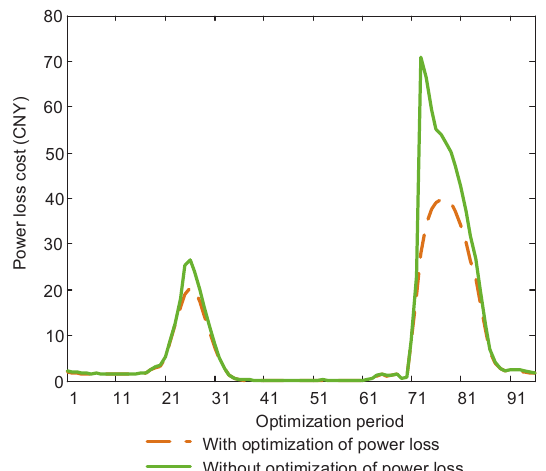
Figure 11. Power loss cost comparison between with and without optimization of power loss on Day 1 of Scenario 1.